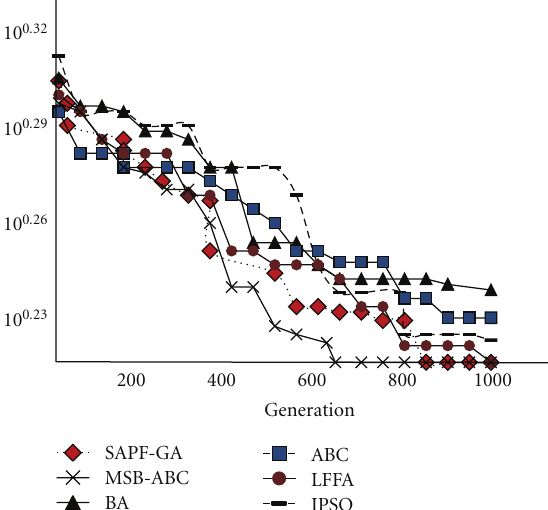
Figure 9: Performance of tested algorithm in γ 0 = 1 . 36 and k 1 = 0 . 00009.